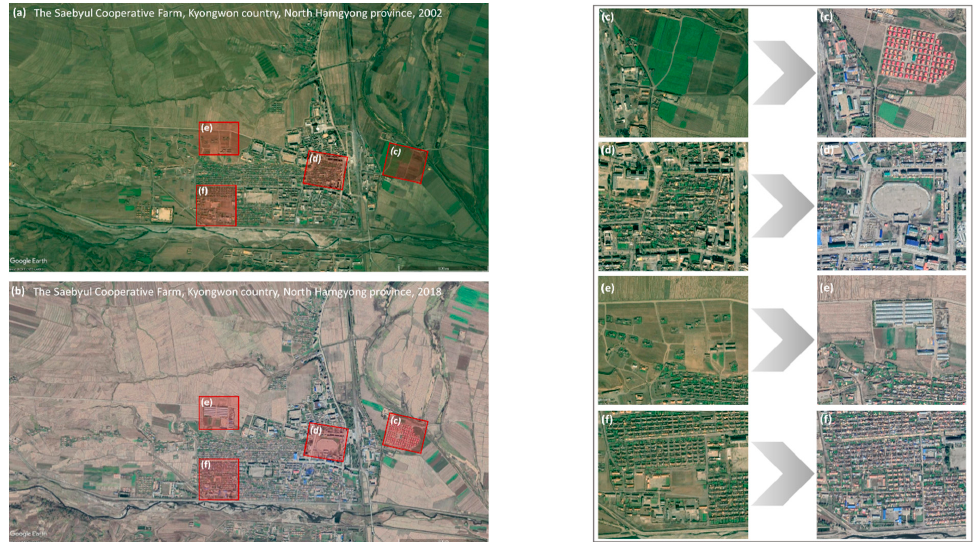
Figure 7. Morphology and urban structures of the Socialist lifestyle are discovered in the cooperative farmland in 2002 ( a ) and 2018 ( b ). ( c ) Changes in land use from farmland to residential areas; ( d ) changes in land use with more community-oriented development; ( e ) showing newly-built agricultural facilities; ( f ) changes of residential development at higher densities (image sources: Google Earth, date of access: 17 October 2019).